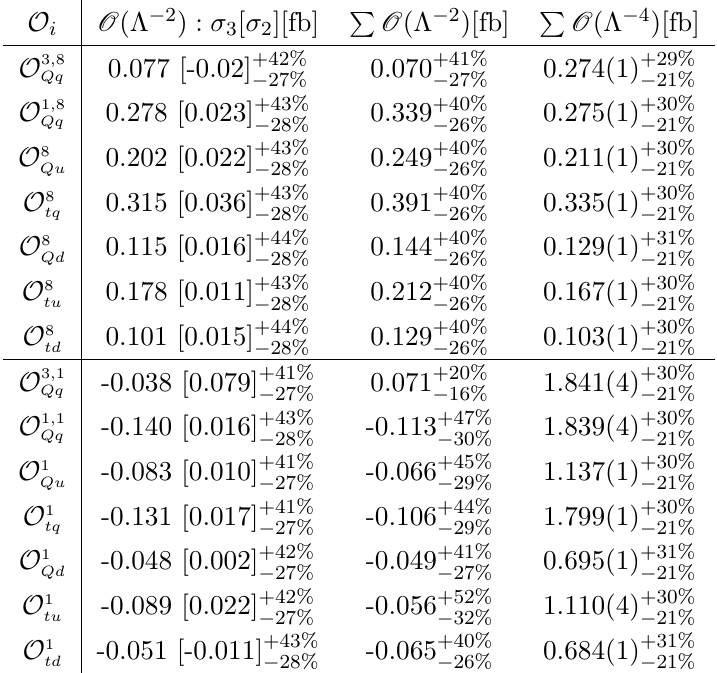
Table 9 . Same as table 8 but for the 2-heavy 2-light operators.